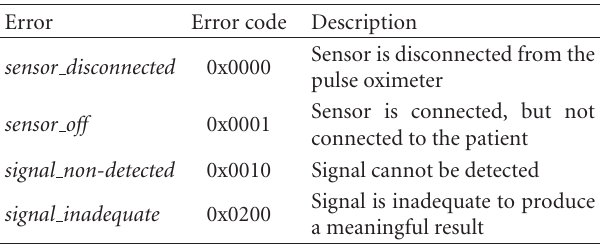
Table 1: Operational errors detected and reported by the PHD